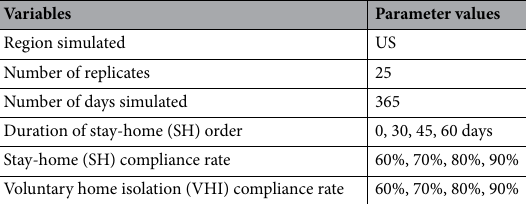
Table 2. Variables used in the simulation experiments.